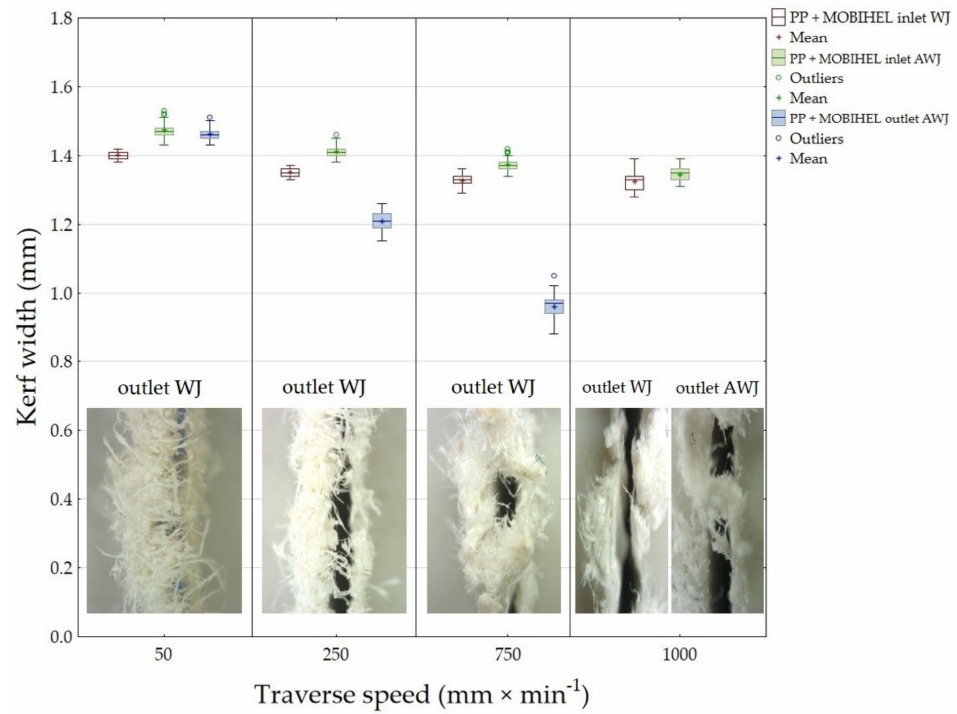
Figure 11. Dependence of the cutting gap width on the cutting head traverse speed and waterjet type for PP + MOBIHEL.